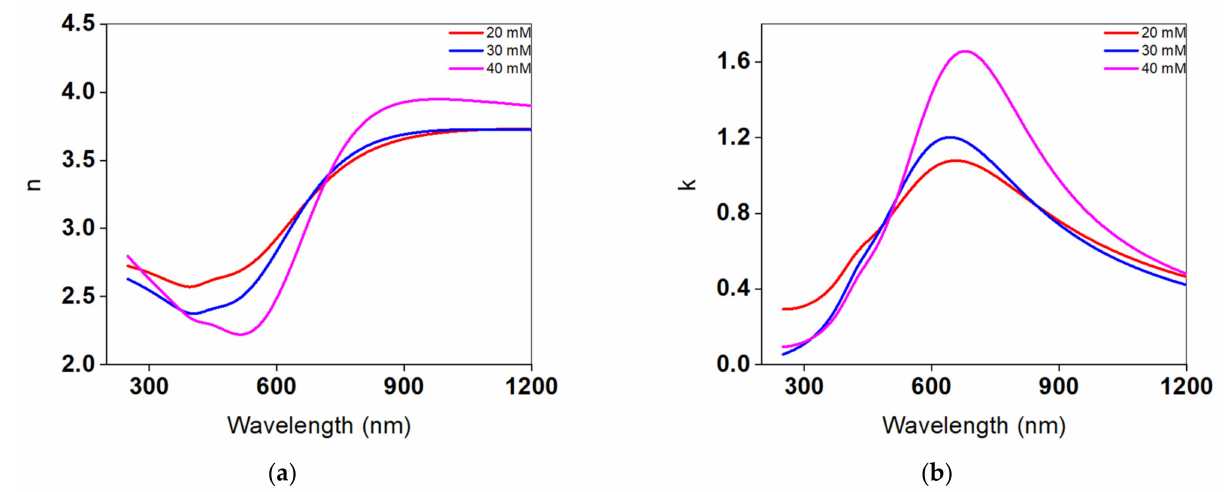
Figure A7. Refractive index (( a ) n) and extinction coefficients (( b ) k) of AgNPs/PMMA samples at different